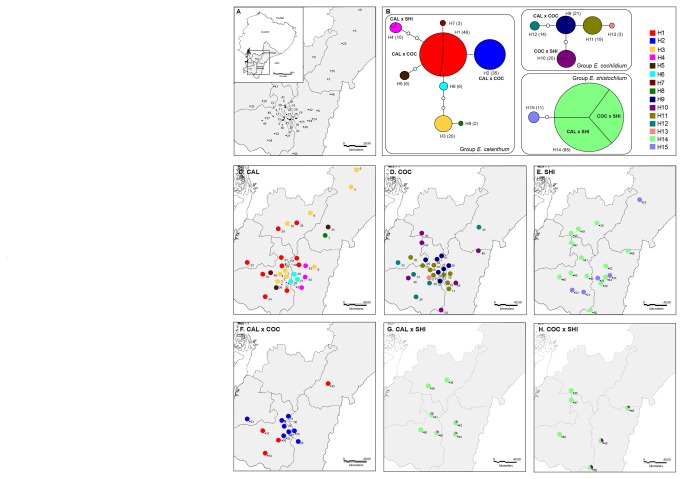
Patterns of haplotype variation in three hybridizing species of Epidendrum (N = 304 plants).A) Statistical parsimony network of plastid haplotypes based on sequences from four chloroplast regions (trnL-trnF, rps16, psbA- trnH and rpl16), a circle’s size being proportional to the haplotype frequency. Small empty circles represent single mutational steps. B) Geographic distribution of plastid haplotypes.